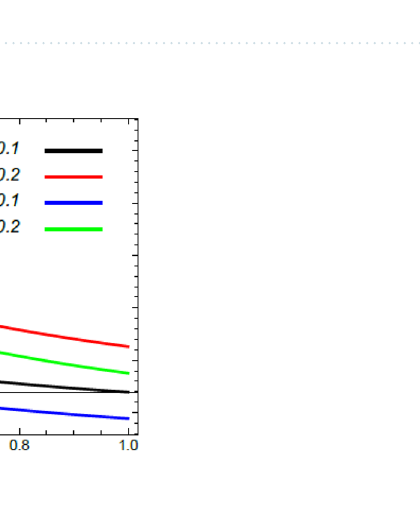
Figure 32. Sherwood number versus M as given in Eq. (38) to illustrate the impact of the Stefan blowing factor S w and Schmidt number S c